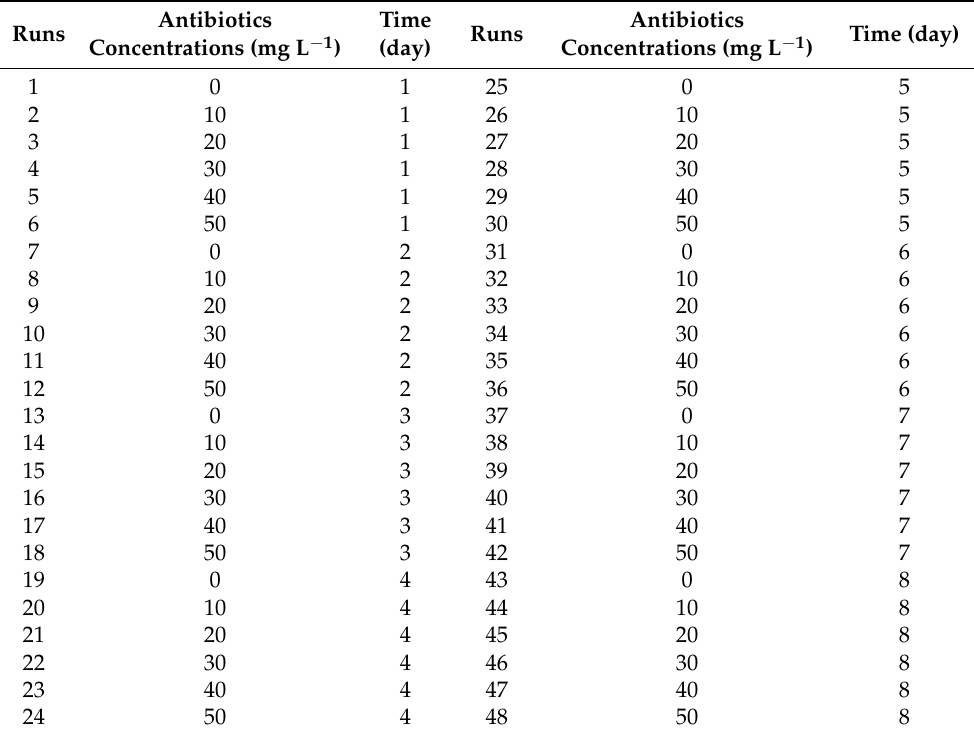
Table 5. Experiments for toxicological effects of antibiotics on